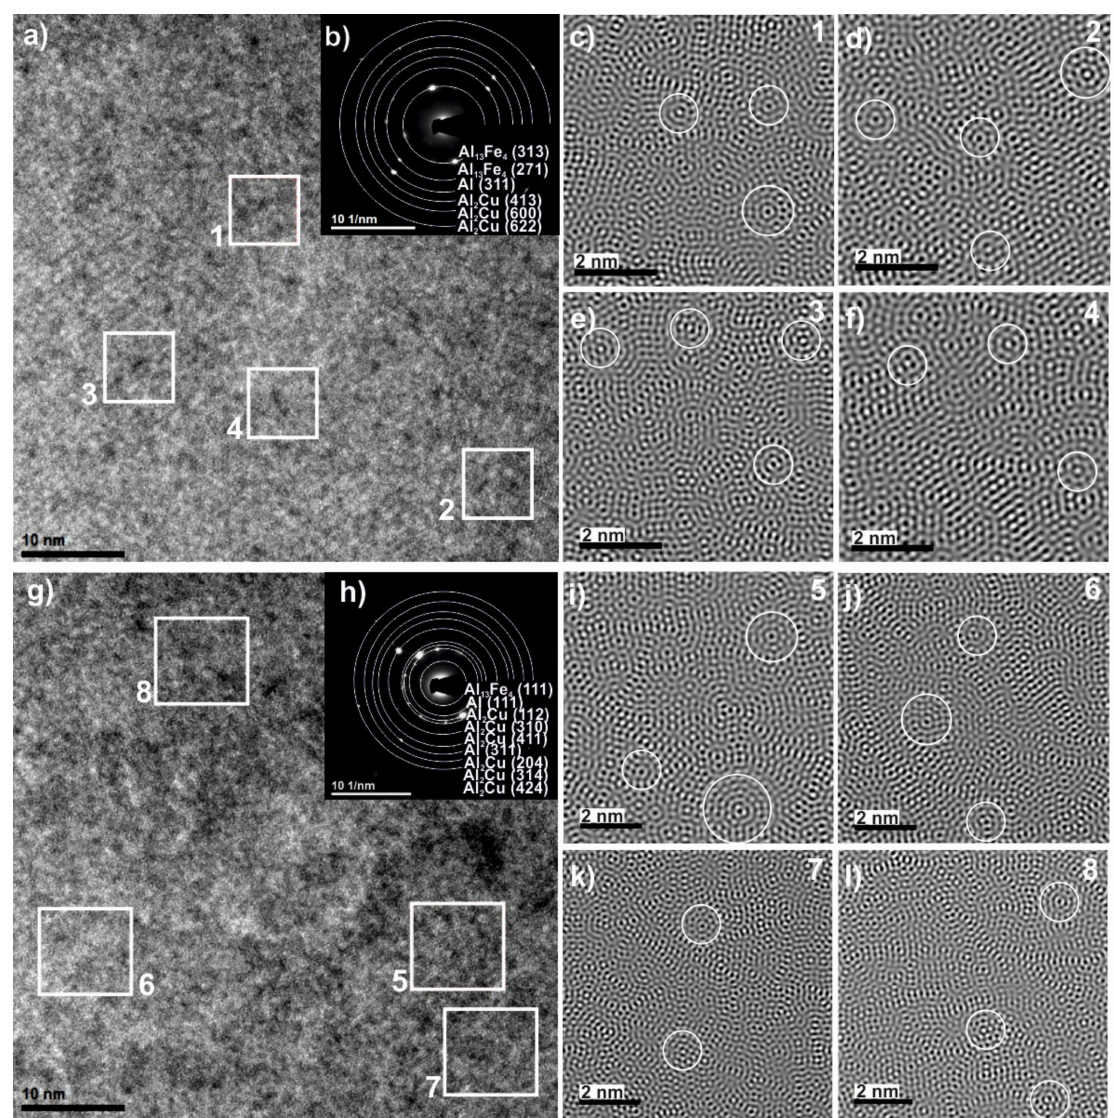
Figure 3. High-resolution transmission electron microscopy (HRTEM) images ( a , g ), selected area electron diffraction (SAED) patterns ( b , h ) of Al 65 Cu 20 Fe 15 alloy in the form of ribbon and inverse Fourier transfer (IFT) images ( c – f , i – l ) from selected areas